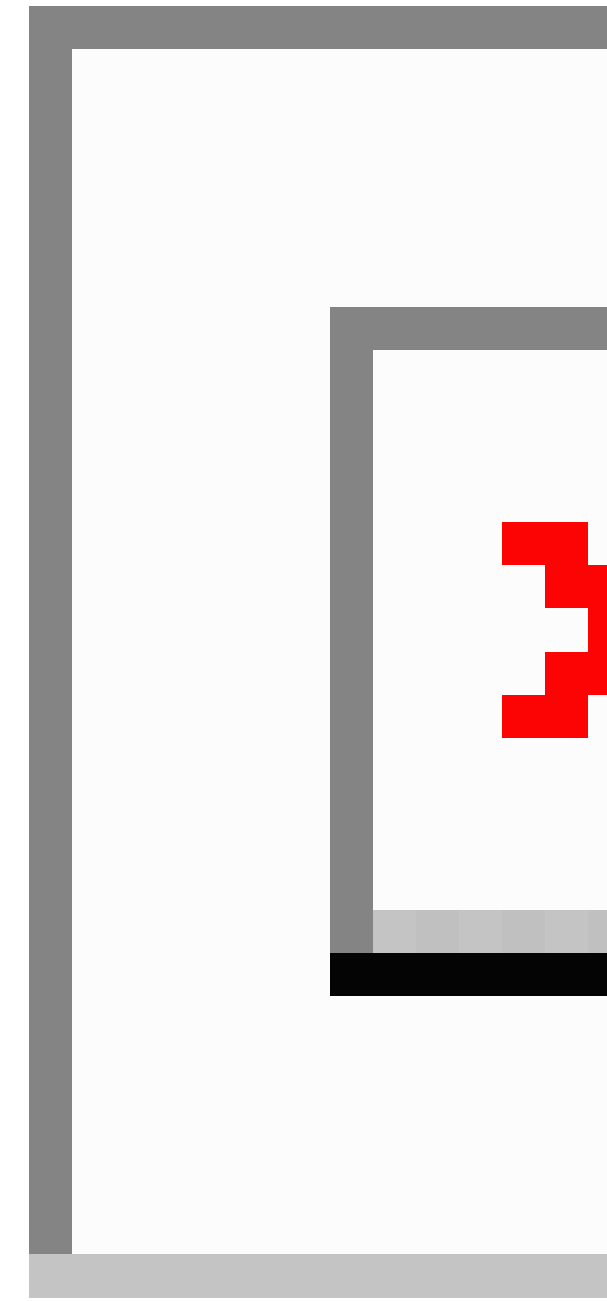
Figure 2. Screenshot of the